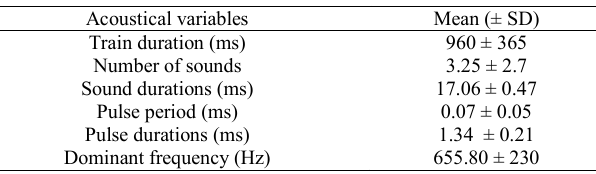
Table 1. Acoustical variables for pectoral sound, ms = milliseconds, Hz = Hertz. Number of sounds analyzed n = 152, pulses number analyzed n = 672.